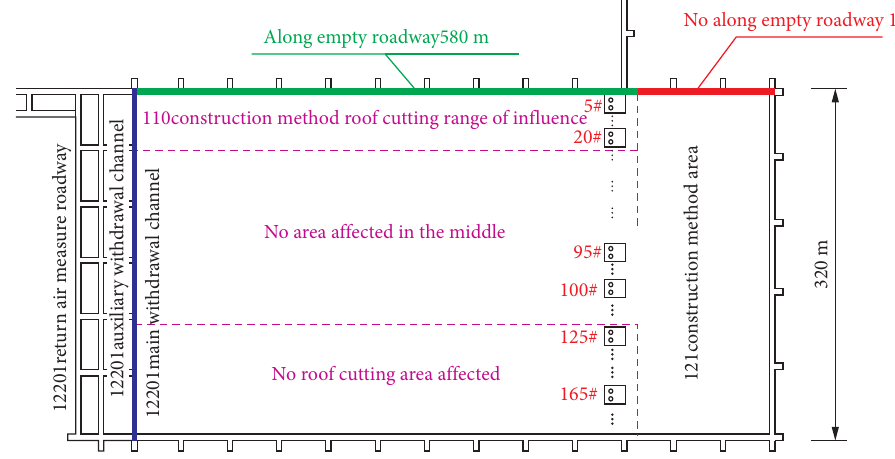
Figure 4: Division of the roof-cutting and pressure-relief roadway retaining